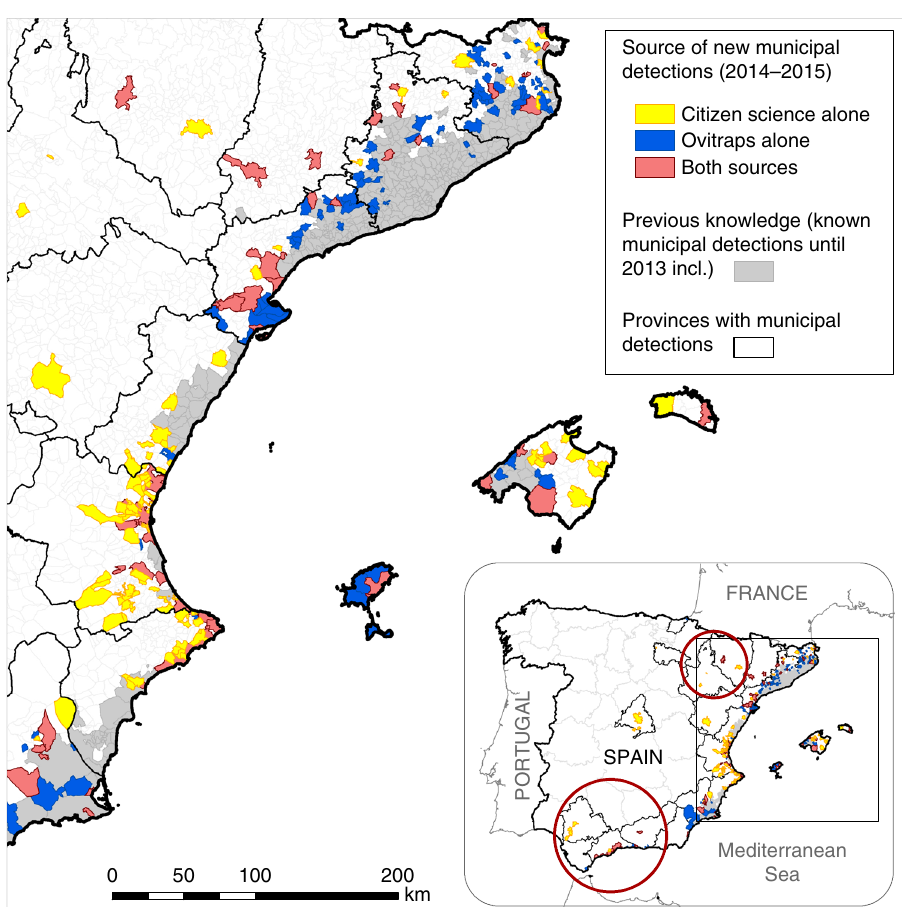
Fig. 1 Range of expansion of the tiger mosquito in Spain (Canary Islands, Ceuta and Melilla excluded) in 2014 – 2015. Provinces with municipal-level detections are highlighted. Grey areas denote state of knowledge at the municipal level based on ovitrap surveillance through 2013 (source data from ref. 17). Other colours indicate municipal detections during 2014 – 2015 by expert validated reports from citizen science (yellow), ovitrap surveillance (dark blue) and both methods (light red) (source data from refs. 17, 18). Red circles indicate areas far from the main invasion front, from which the discoveries of the species were corroborated in the fi eld using ovitraps, but triggered by citizen science 32,33 . Boundary data from Spanish National Geographic Institute 53